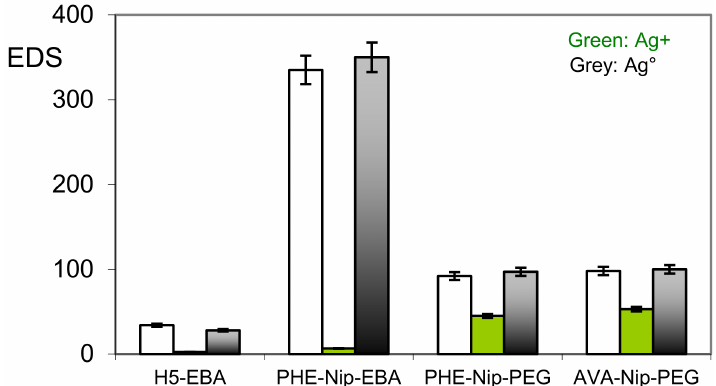
Figure 4. Equilibrium degree of swelling (EDS) of hydrogels in the native state, in the complexation state with silver ion, and in the embedded state with silver nanoparticles.